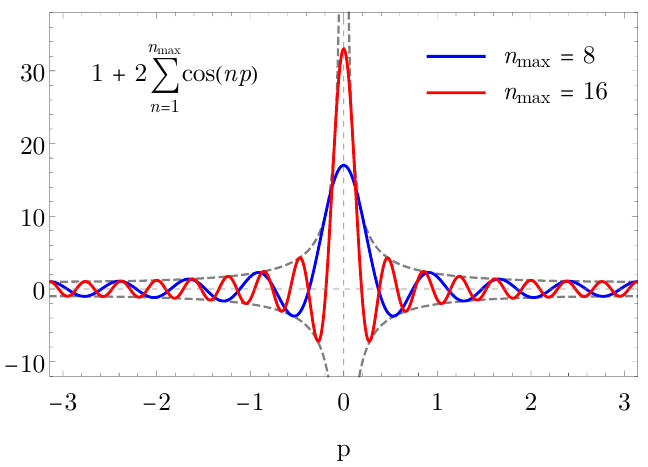
Figure 1 . The series de(cid:12)ned in eq. (1.6) converges to the delta function in a distributional sense, but at any given point p = 0 the partial sums of the series oscillate with an amplitude that is (cid:12)xed 6 by the value of p . The envelope of this oscillation is given by 1 = sin( p= (cid:6)